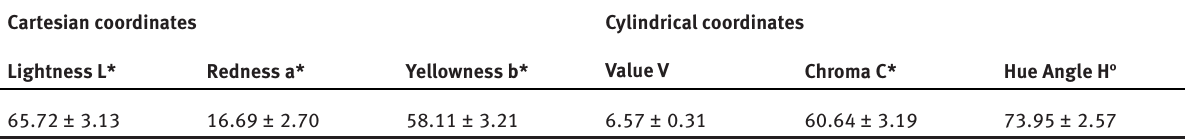
Cartesian coordinates